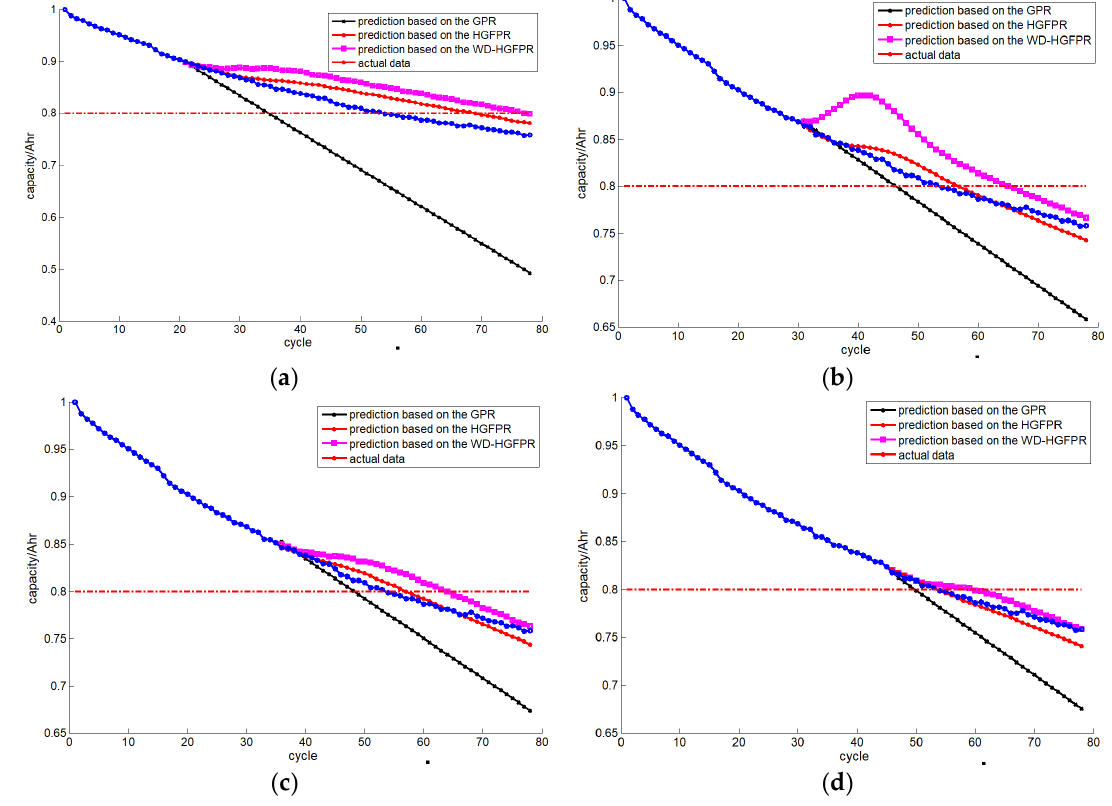
Figure 7. Prediction results using different models with different lengths of training data for Cell-1 battery. ( a ) RUL prediction results with 20 training data, ( b ) RUL prediction results with 30 training data, ( c ) RUL prediction results with 35 training data, and ( d ) RUL prediction results with 45 training data.